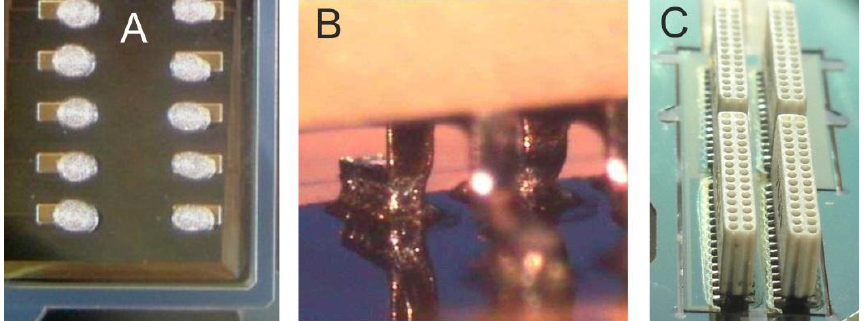
Figure 9. ( A ) Solder paste dispensed on pads; ( B ) Soldered connector leg; ( C ) Four soldered connectors after flux-clean.